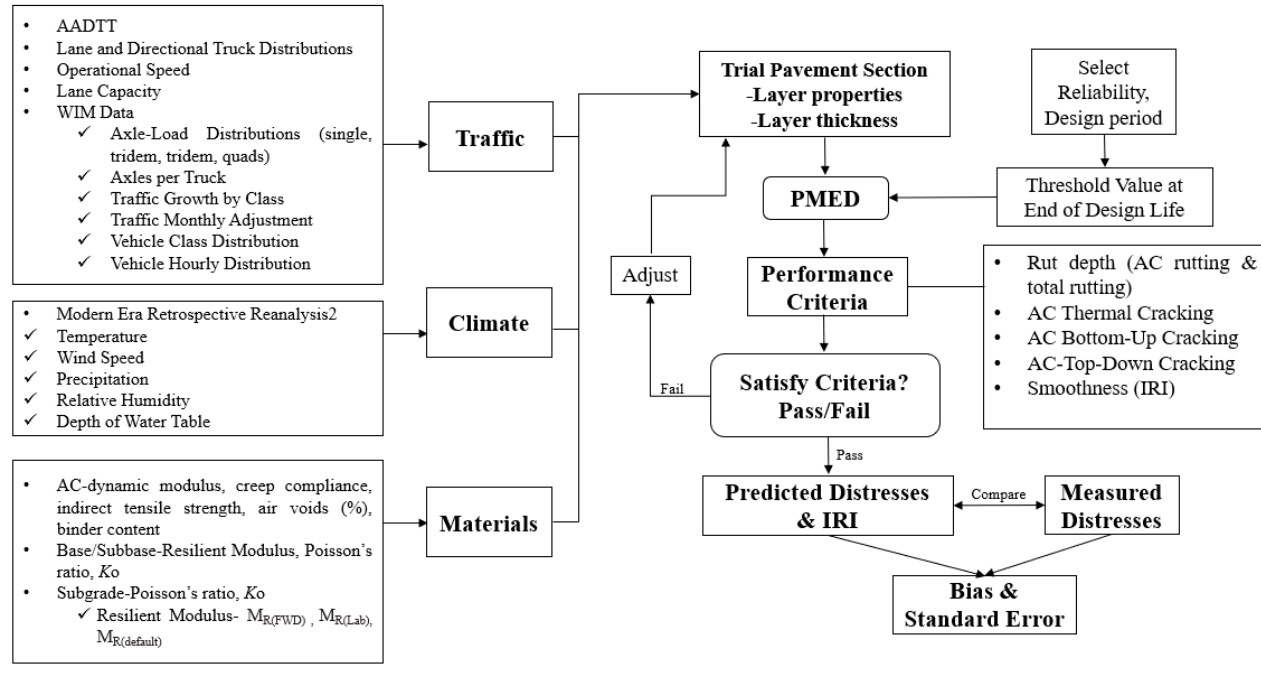
Figure 3. Flow chart of the study.